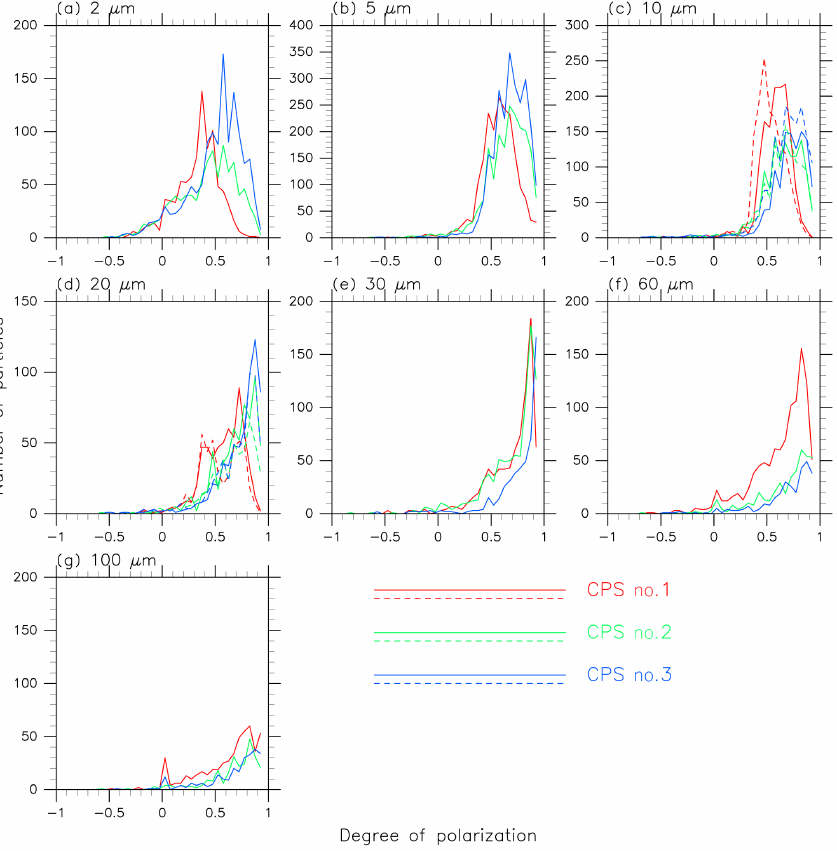
Figure A2. Frequency distributions of the degree of polarization (DOP) in 0.05 bins from the laboratory experiments using the standard spherical particles of (a) 2µm, (b) 5µm, (c) 10µm, (d) 20µm, (e) 30µm, (f) 60µm, and (g) 100µm diameters. Red, green, and blue curves are for the CPS nos. 1, 2, and 3 instruments, respectively. For the 10 and 20µm particles (c, d) , two sets of experiments on different days are expressed with solid and dotted